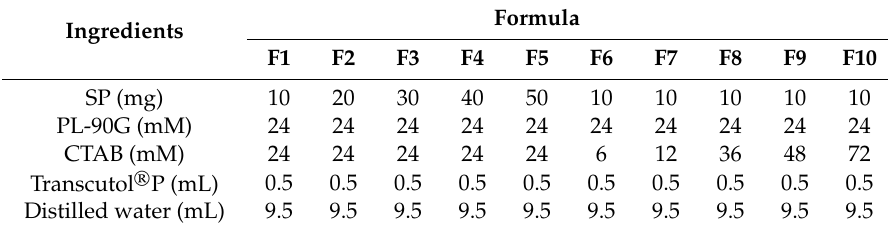
Table 1. Composition of di ff erent SP LeciPlex formulations.